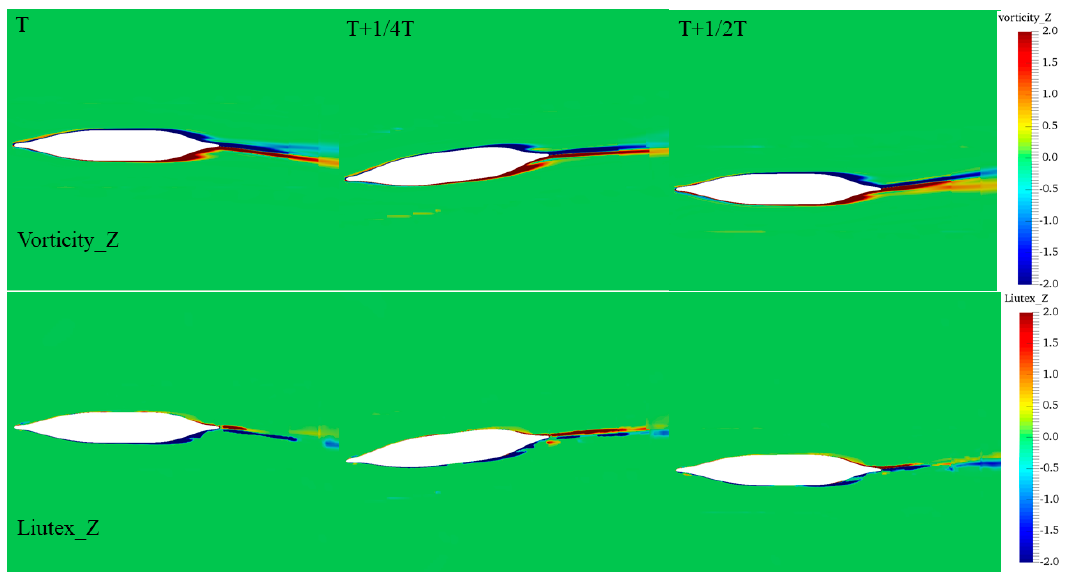
Table 8. Comparison of the different vortex identification methods.